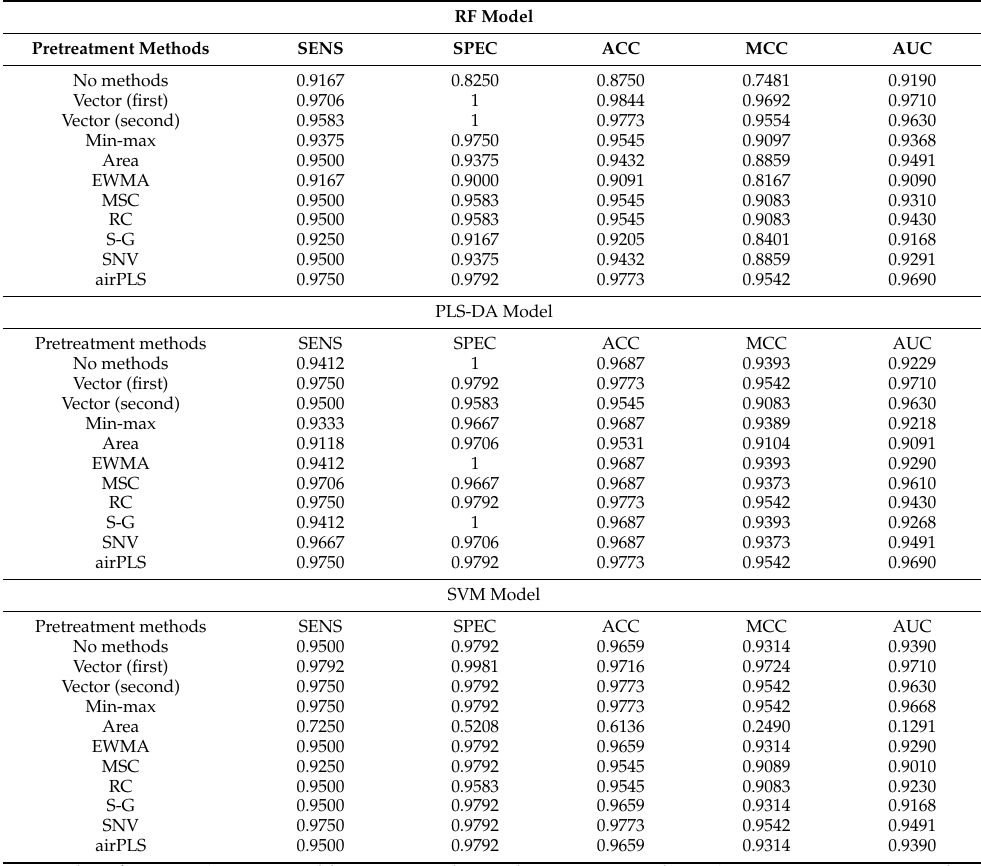
Table 2. Comparing the performance of RF, PLS-DA, and SVM models according to various normal- ization and spectral filter transformations between LJF and LF